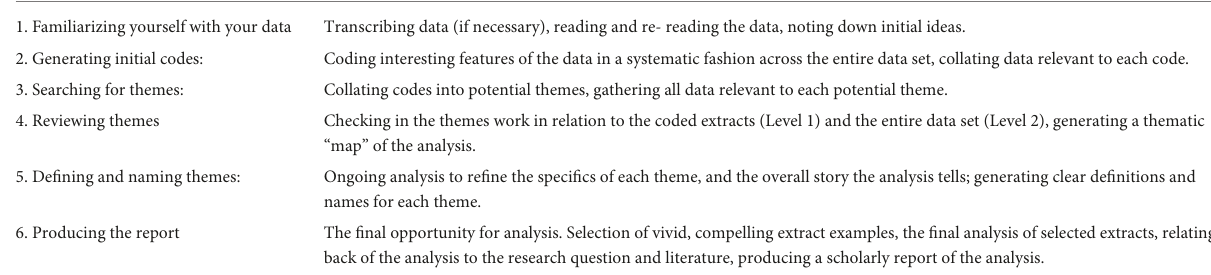
TABLE 2 Six phases of thematic